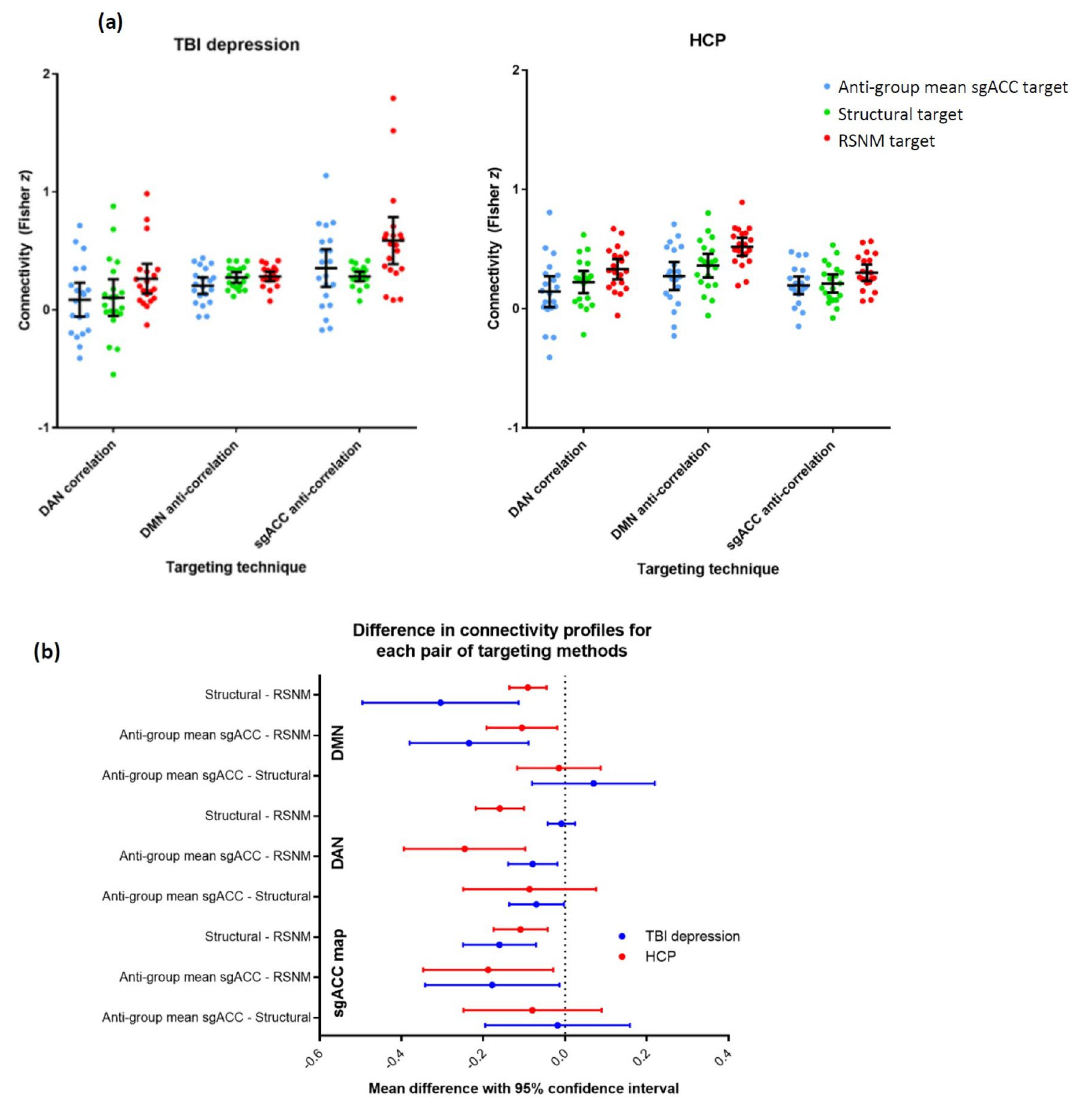
Figure 3. Functional connectivity of targets yielded by the three approaches. ( a ) Functional connectivity of RSNM, sgACC-derived, and structural targets with DAN, DMN, and the normative sgACC connectivity map in each group. ( b ) Differences in connectivity profiles between the three potential targeting methods. On most metrics, RSNM targets showed significantly stronger connectivity with all three regions of connectivity (Fig. S3c), as well as a decrease in FC with a voxel cluster in the dorsomedial prefrontal cortex (r > 0.7, corrected p < 0.05) (Fig. S3d). Baseline predictors of clinical efficacy. For both stimulation sites, rTMS treatment efficacy was related to baseline connectivity of the stimulation site. For the right stimulation site, antidepressant response was sig- nificantly predicted by baseline anti-correlation with bilateral sgACC, anti-correlation with motor cortex, and positive correlation with dorsal ACC (corrected p < 0.05) (Fig. 6a). For the left stimulation site, antidepressant response to rTMS was predicted by baseline correlation with right precuneus and anti-correlation with right sgACC, bilateral lateral parietal lobe, and bilateral dorsomedial prefrontal regions traditionally associated with the resting-state salience network (corrected p < 0.05) (Fig. 6b). Permutation testing confirmed that this whole- brain map was stronger than expected by chance for the right stimulation site (p = 0.04), but not the left stimula- tion site (p = 0.27). Antidepressant response was inversely correlated with the right-sided stimulation site’s FC with the a priori subgenual ROI (Fig. 6c, top panel; Spearman rho = 0.70, p = 0.03). The left-sided stimulation site showed a trend in the same direction, but did not reach significance (Fig. 6d, top panel). The voxel-wise maps of connections that predicted antidepressant response (Fig. 6a,b) suggested that this effect was more prominent for specific subgenual regions that were only partially overlapping with the predefined